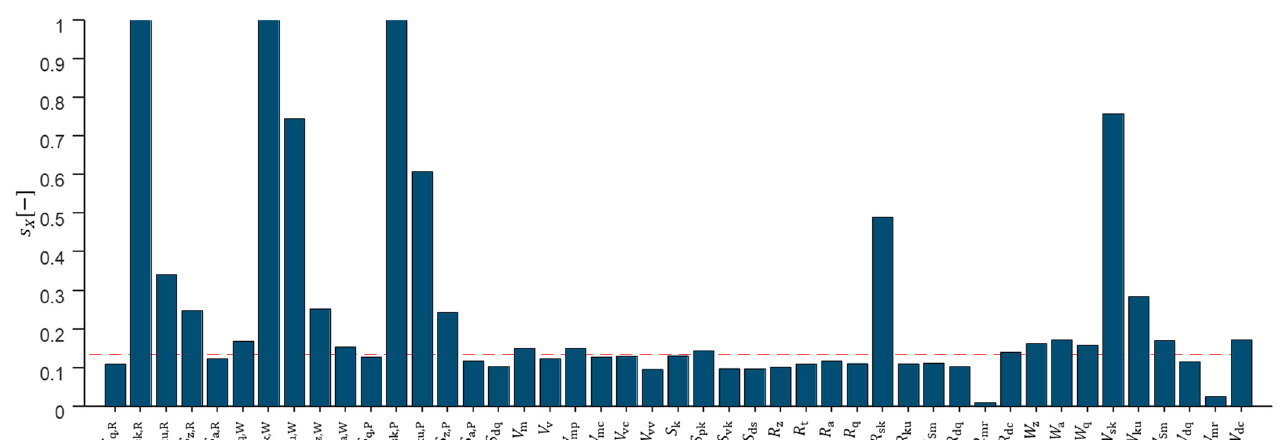
Figure 10. Relative variation of the investigated surface properties in comparison to the variation of the assessed damage grade (dashed line). the assessed damage grade (dashed